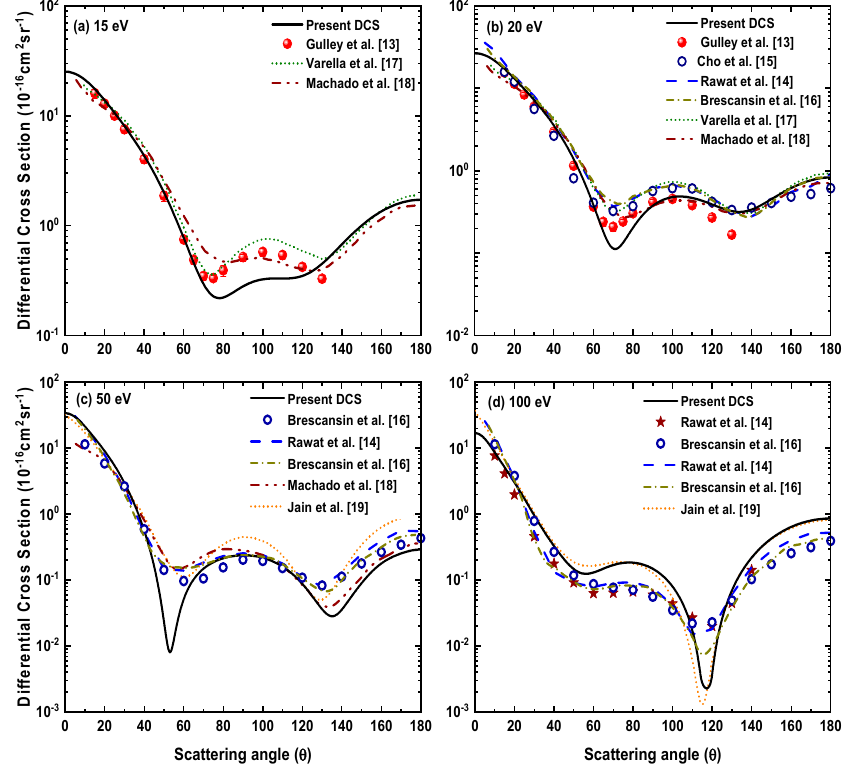
Figure 3. Differential cross sections for electron − H 2 S scattering at incident electron energies ( a ) 15 eV, ( b ) 20 eV, ( c ) 50 eV and ( d ) 100 eV.